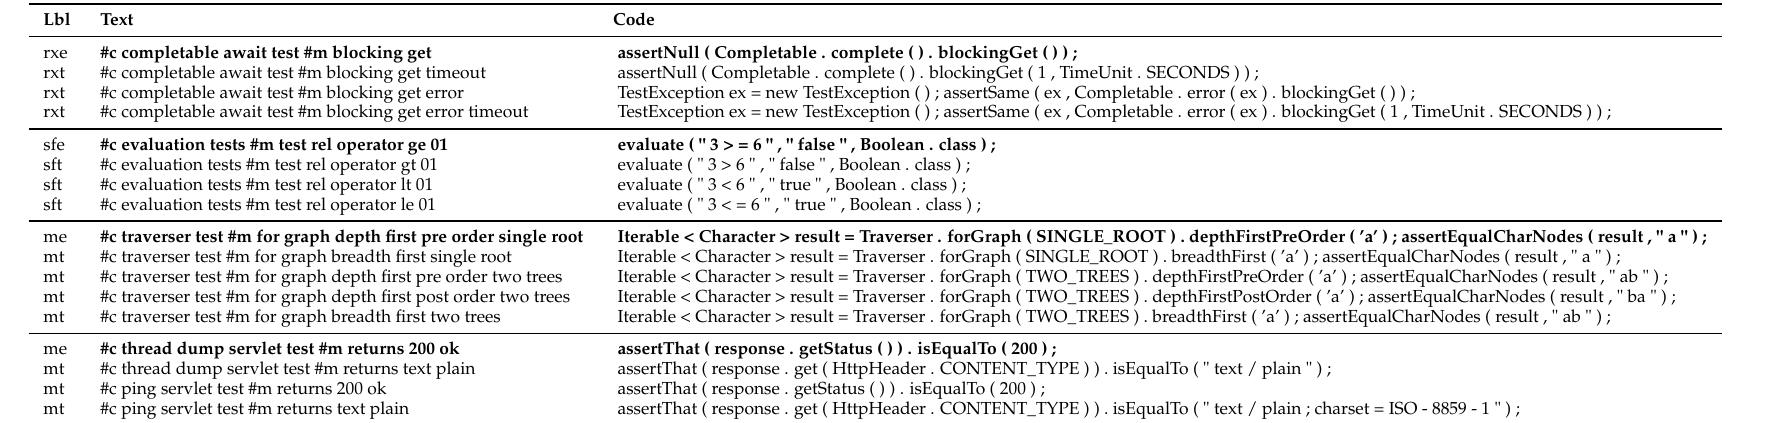
Table 4. Examples of correctly predicted unseen functions, together with seen instances that provided necessary information. Each row in the table contains the following data: Lbl (label)—created by concatenating the dataset label (rx, sf, m for multi) with a suffix indicating whether the text-code pair comes from the test set (suffix e) or the trainset (suffix t). ; Text—the quasi-natural description (input sequence); Code—the test code (output sequence). Text-code pairs coming from the test set (rxe, sfe, me) are additionally highlighted in